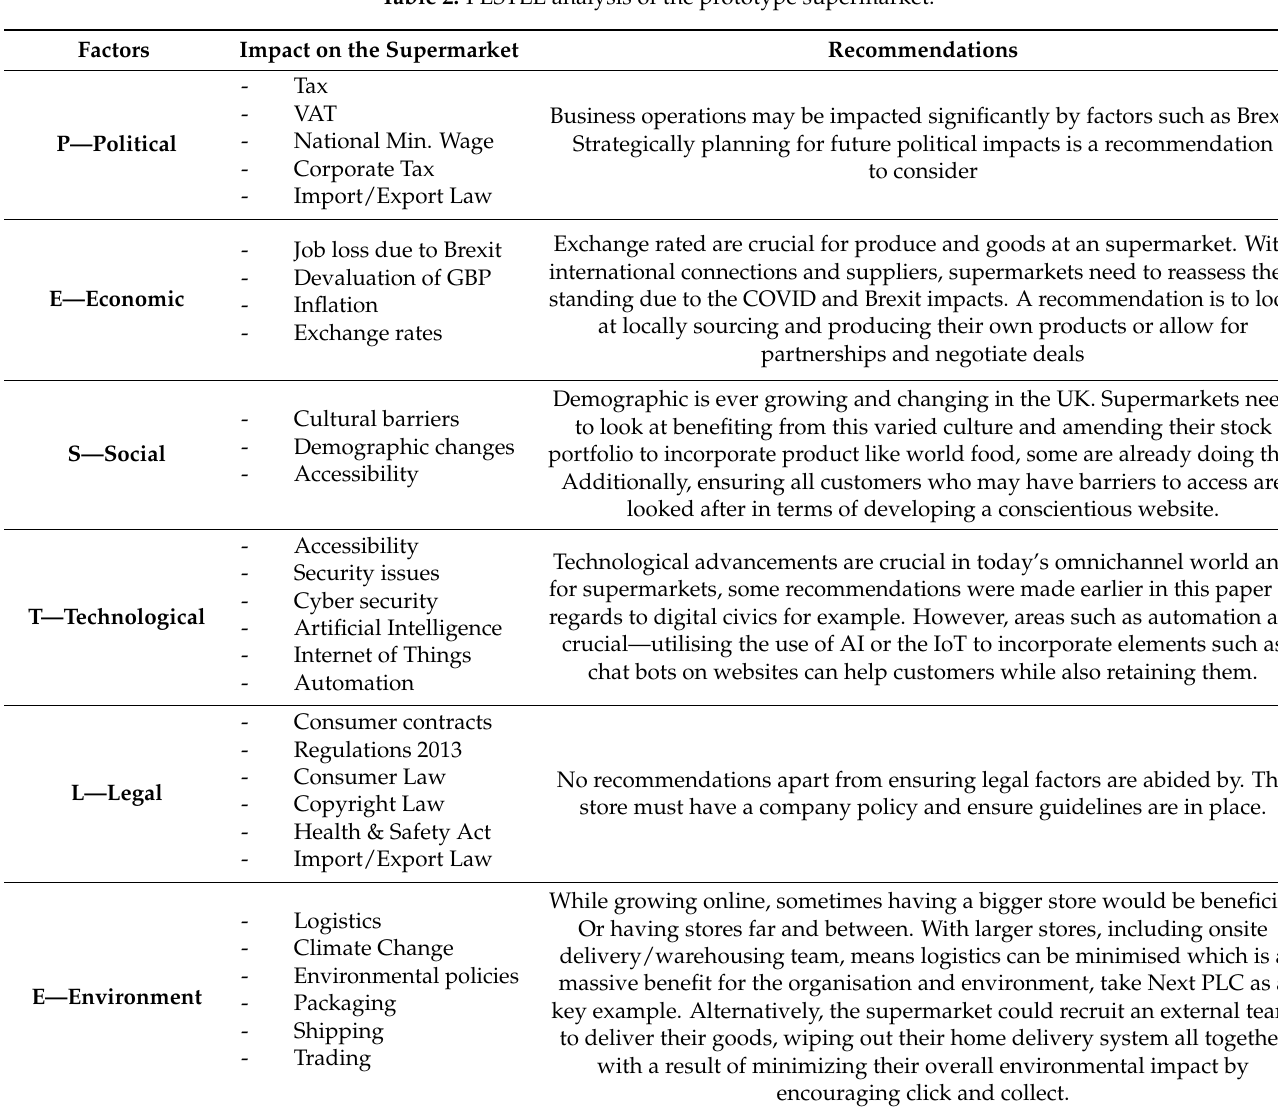
Table 2. PESTLE analysis of the prototype